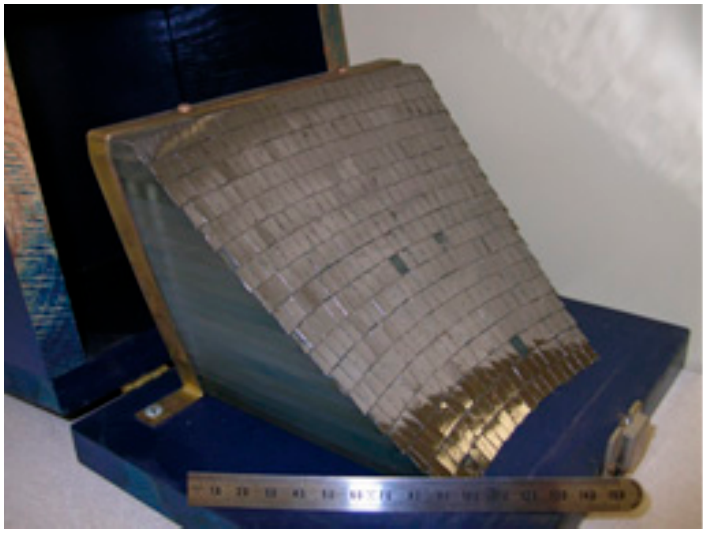
Figure 5. Photograph of the engineering model of the OSO-8 graphite crystal panel.